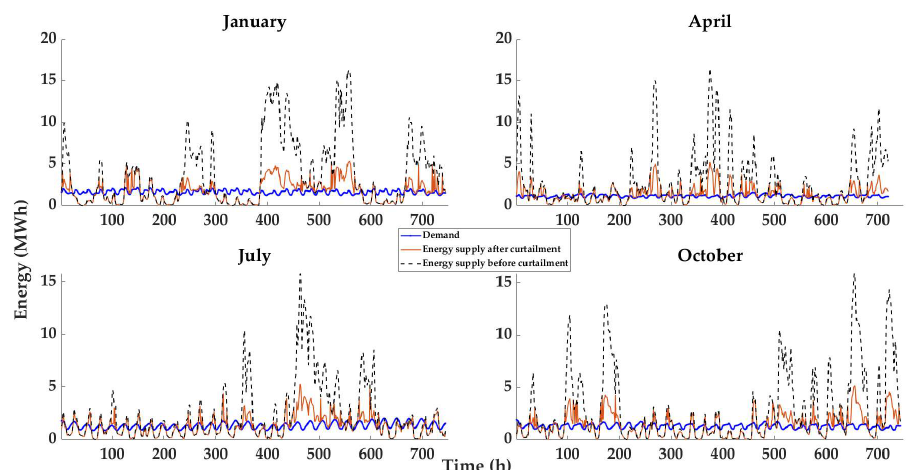
Figure 13. Demand vs. supply before and after optimization—seasonal comparison.